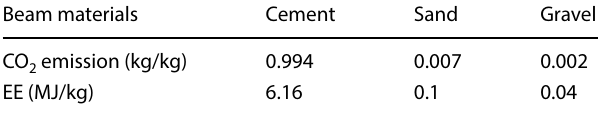
Table 7 ALCORN method factors [27–29]